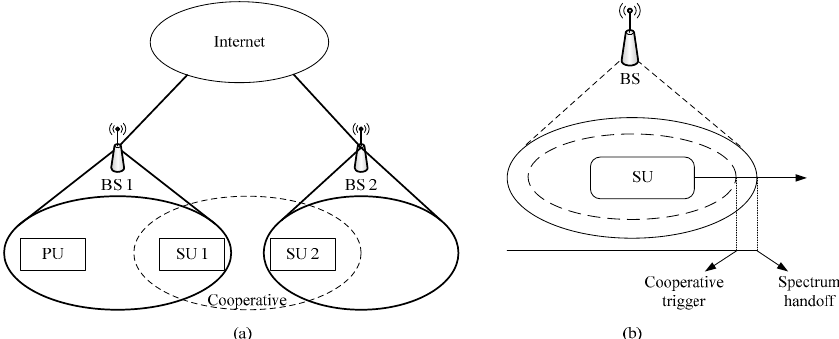
Figure 6. ( a ) Cooperation-assisted mechanism and ( b ) cooperation trigger timing.